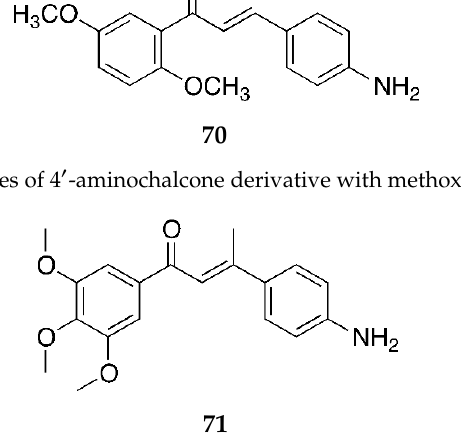
Figure 36. Chemical structures of the 4′-aminochalcone derivative with methoxy substitutions on ring